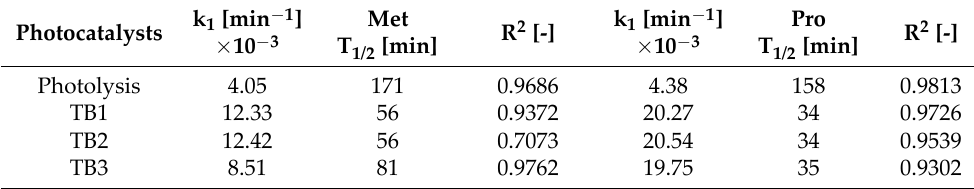
Table 3. Kinetics of Met and Pro